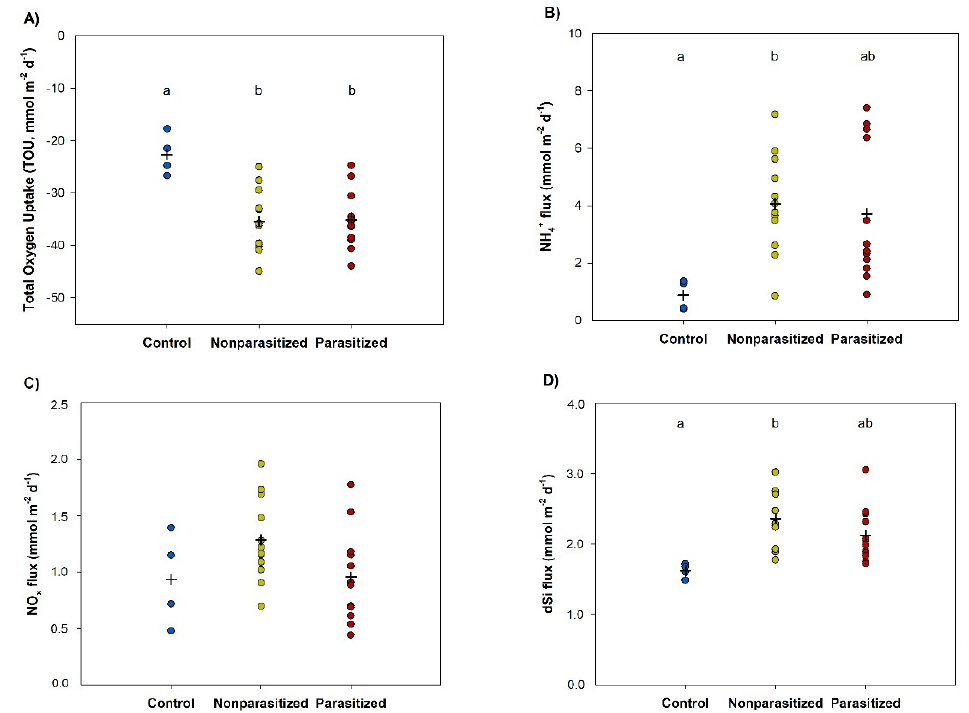
Figure 3. ( A ) Total oxygen uptake and fluxes of ( B ) ammonium, ( C ) nitrate and nitrite, and ( D ) dissolved silicate across the sediment–water interface (data are represented by points; black crosses correspond to the mean value) for the three treatments (“control” ( n = 4), “nonparasitized” ( n = 12), and “parasitized” ( n = 12)). Different letters indicate significant differences ( p < 0.05) among treat- ments after performing a pairwise t -test with Bonferroni correction when one-way ANOVA was significant ( p <